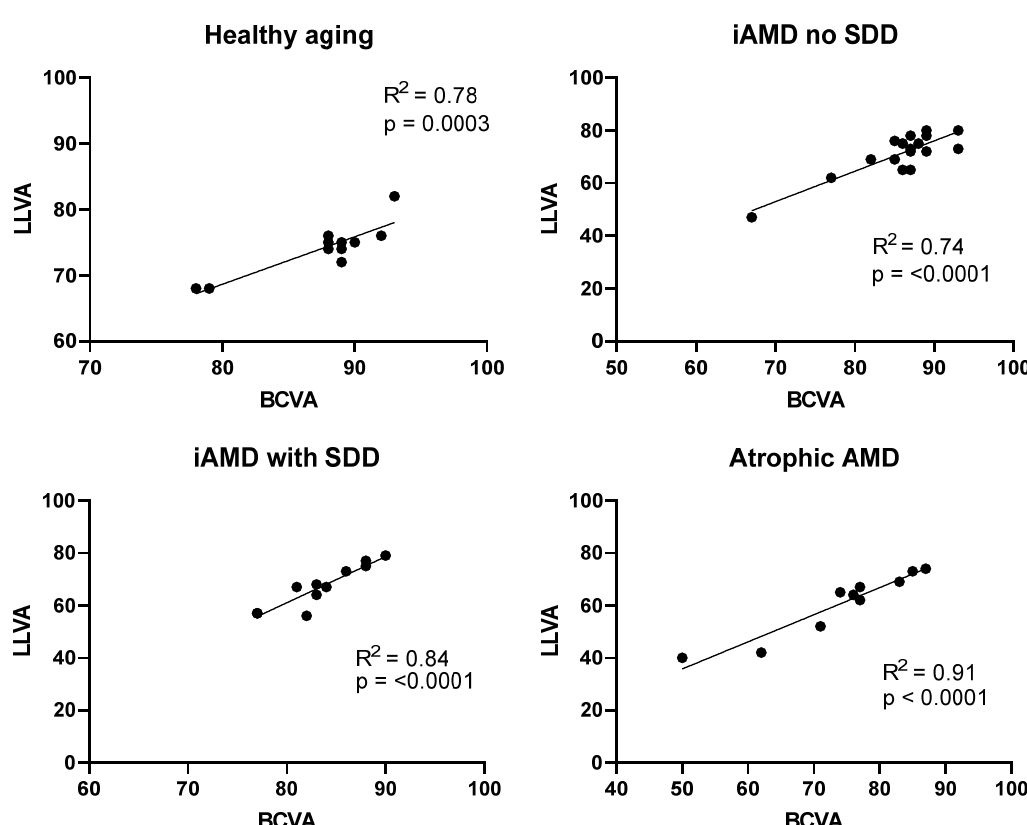
Figure 1. Scatter plots showing significant relationships between best-corrected visual acuity (BCVA) and low luminance visual acuity (LLVA) in healthy aging (n = 11, R 2 = 0.78, p = 0.0003), iAMD no SDD (n = 17, R 2 = 0.74, p < 0.0001), iAMD with SDD (n = 11, R 2 = 0.84, p < 0.0001) and atrophic AMD (n = 10, one subject was excluded due to a high discrepancy between BCVA and LLVA, R 2 = 0.91, p < 0.0001). iAMD = intermediate AMD, subretinal drusenoid deposits = SDD.